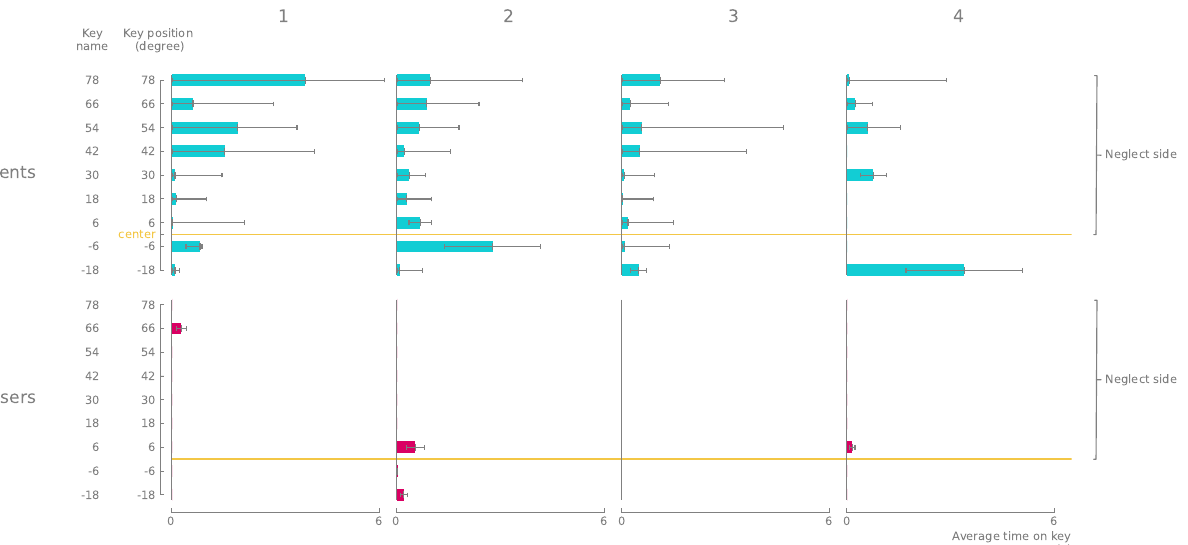
Figure 17. The median of the time for which a ball was lying on the surface for each key during the Free-to-Play task is remarkably higher for the patients than for the test users. Moreover, the spread of the values is wider, as seen by the quartiles Q1 and Q3, indicated by the horizontal lines. For most patients, keys on the extremity of the instrument in their neglected side remained unplayed for the longest. Patients 2 and 4 showed a somewhat similar increase for keys in the